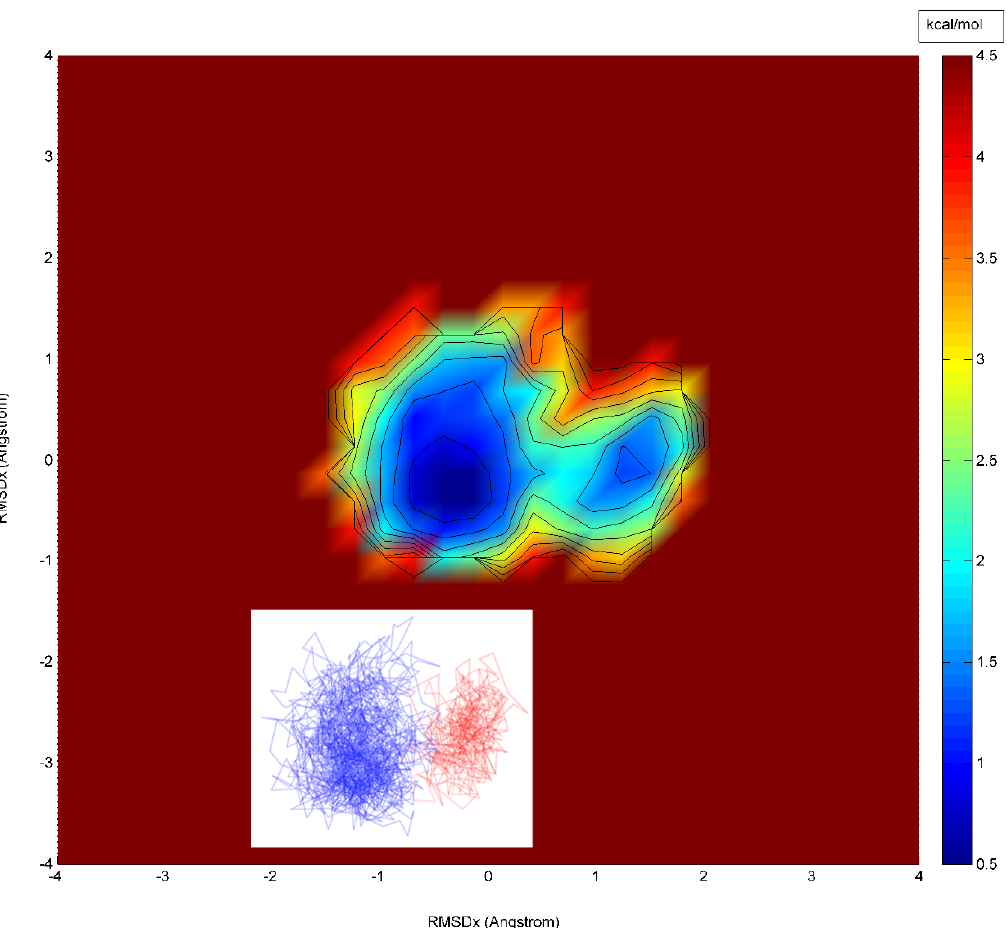
Figure 7. Calculated PCA free energy landscape for an MDUF trajectory on CI2. Color scheme: yellow to green to blue: high to medium to low free energies, respectively.